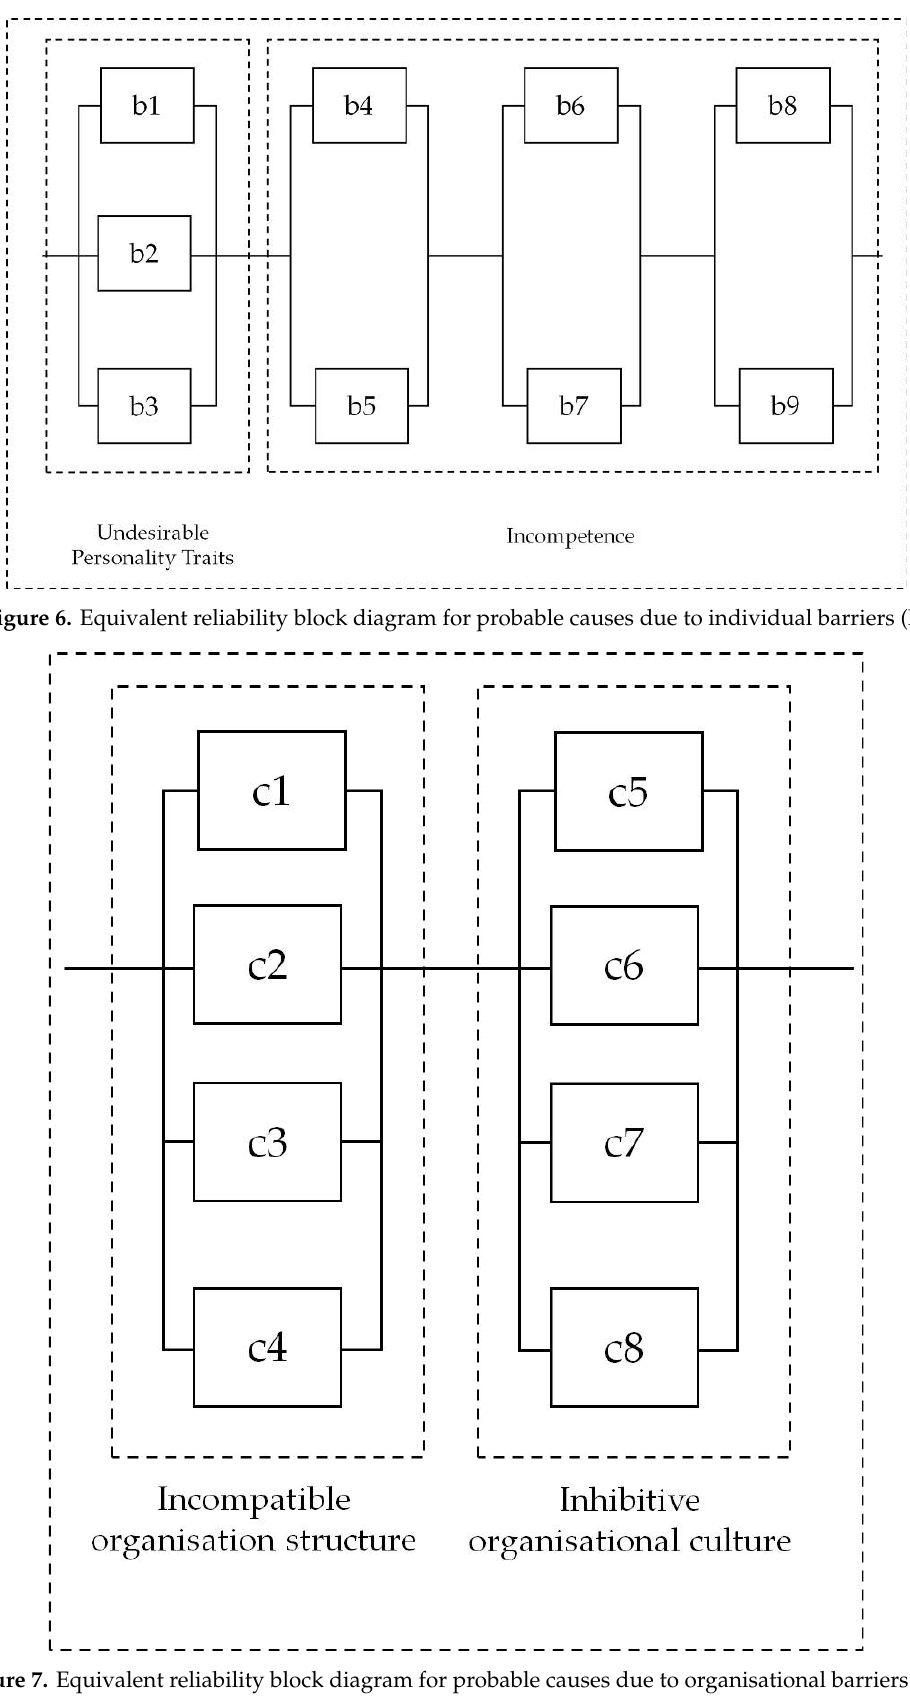
Figure 7. Equivalent reliability block diagram for probable causes due to organisational barriers